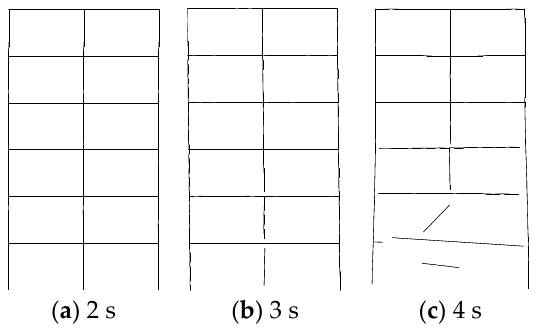
Figure 24. Failure processes of the steel frame with rigid connection.